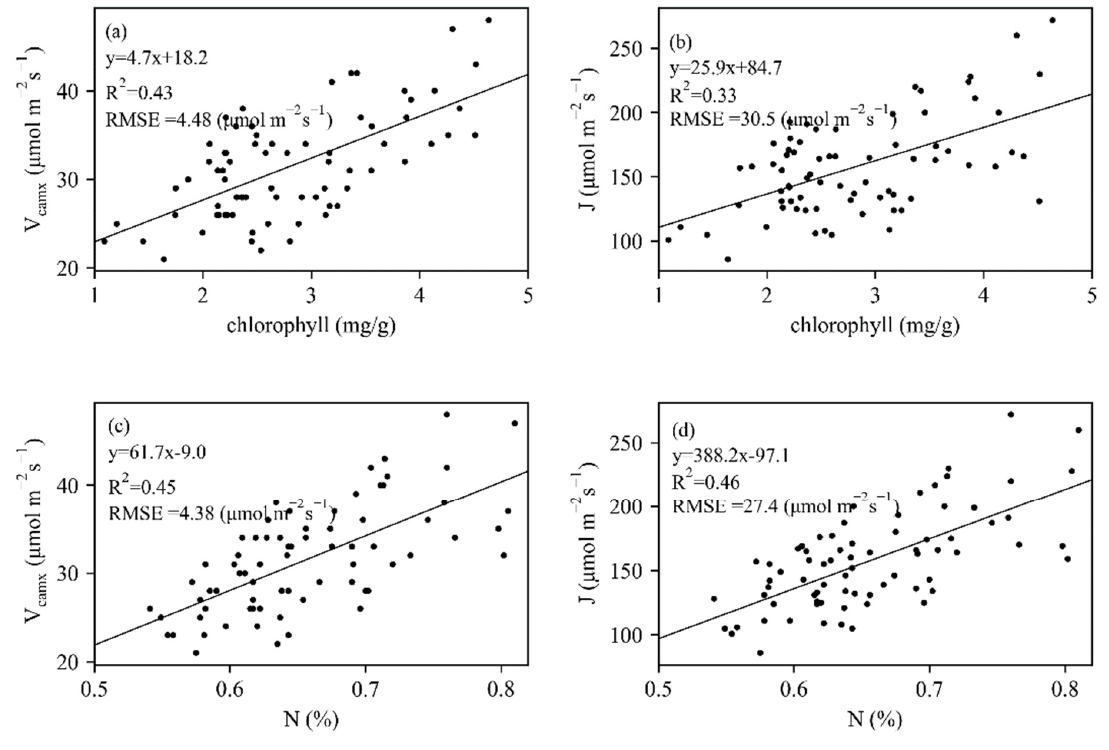
Figure 4. The relationships between biochemical parameters (chlorophyll and N) and ( a , c ) V camx and ( b , d ) J.